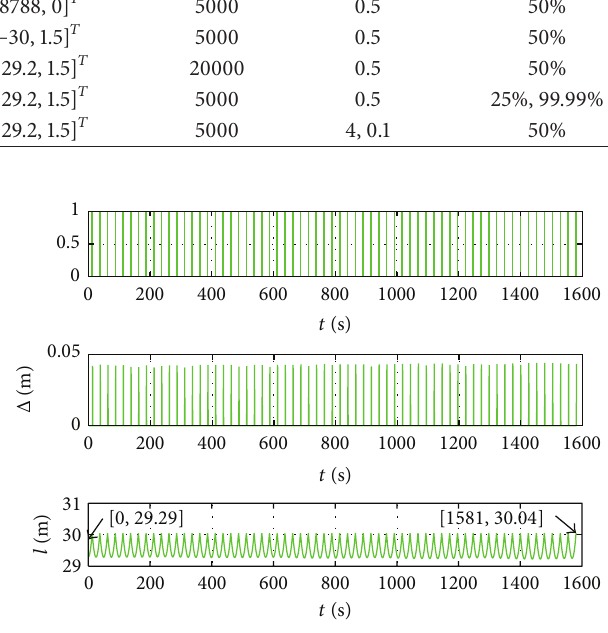
Figure 7: The tensional ( 1 ) and tensionless (0) states, the elongation of the tether ( Δ ), and the distance between two spacecraft ( 𝑙 ) during deorbiting.